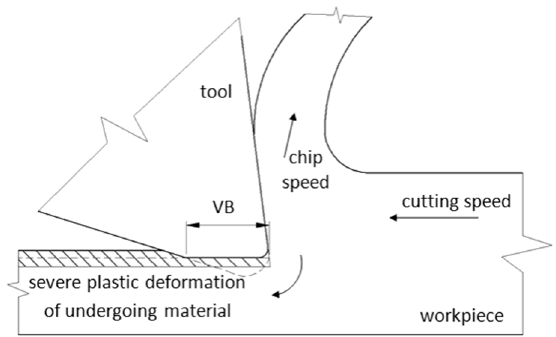
Figure 1. Plastic deformation of undergoing layer and chip separation during hard milling.